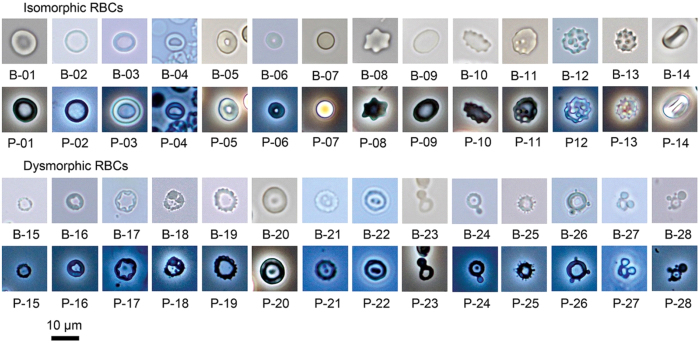
Isomorphic red blood cells (RBCs) and dysmorphic RBCs, 400×.B: bright field microscope; P: phase contrast microscope. Images 01–14 are isomorphic RBCs, and images 15–28 are dysmorphic RBCs.